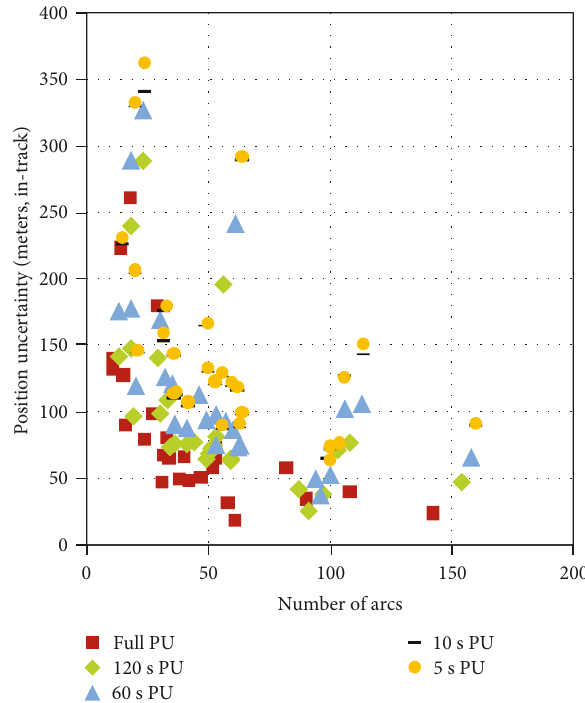
Figure 6: Final in-track direction position uncertainty versus the number of arcs from 7-day estimation for 11 LEOs on the most overlapped event